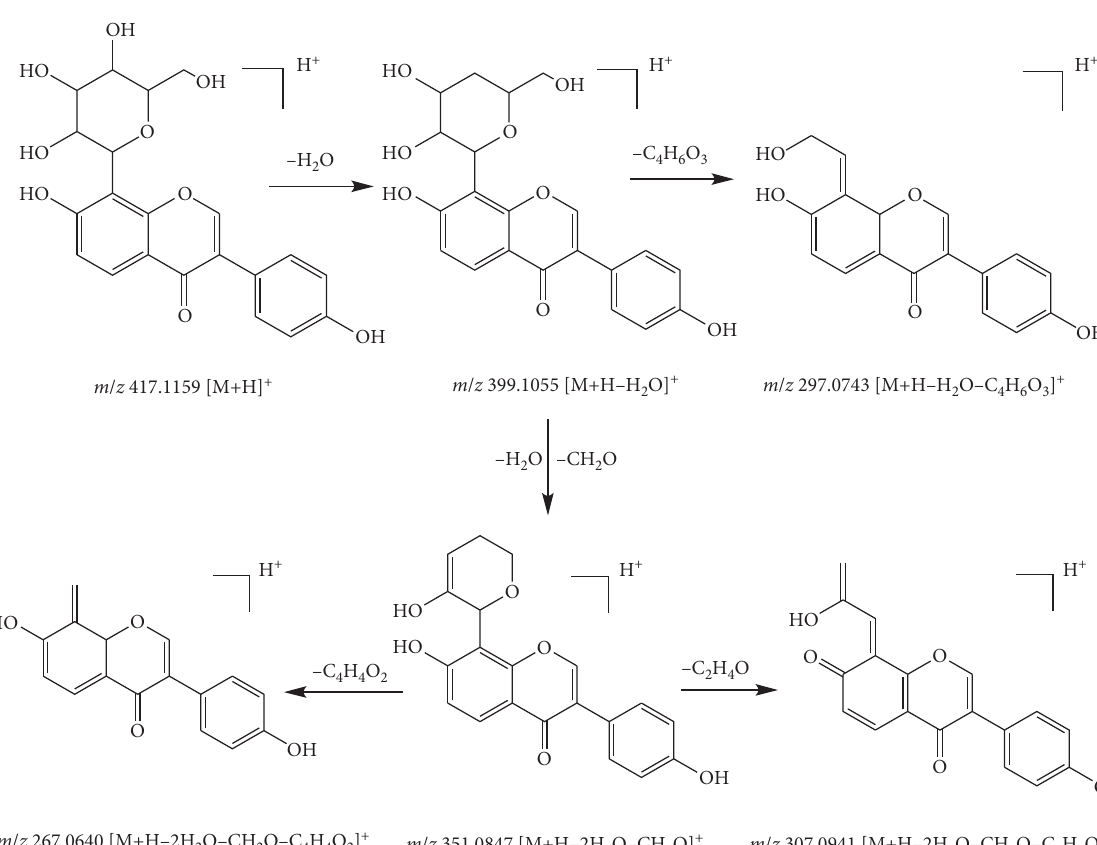
Figure 4: Possible fragmentation pathway of compound